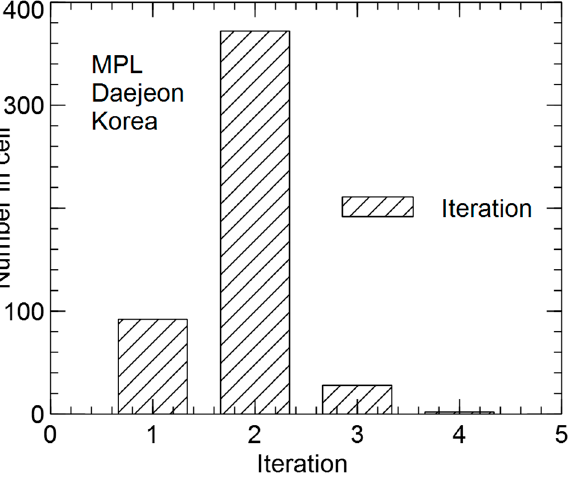
Figure 8. Histogram of the convergence rate of the MPL angular parameter calibration method, Daejeon, Republic of Korea.